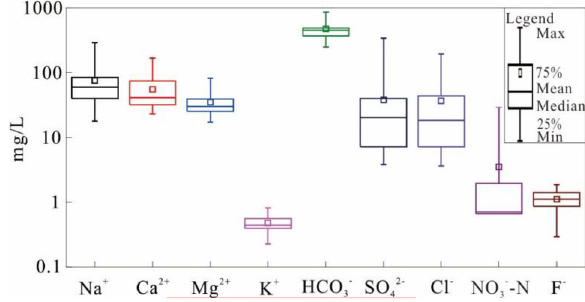
Fig. 2 Box diagram of different